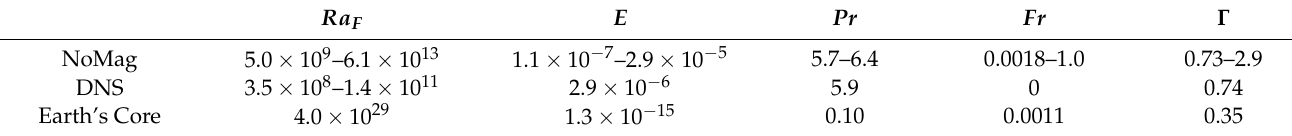
Table 1. RRBC control parameters for NoMag (this study), DNS (this study), and Earth’s core [139]. Ra F is the flux Rayleigh number given by (25), E is the Ekman number given by (8), Pr is the Prandtl number given by (2), Fr is the Froude number given by (9), and Γ is the aspect ratio: for the NoMag and DNS experiments, Γ is defined as the diameter-to-height ratio of the cylinder used/simulated as given by (3), while for Earth’s core, we provide the aspect ratio as the radius ratio of Earth’s core relative to Earth’s entire